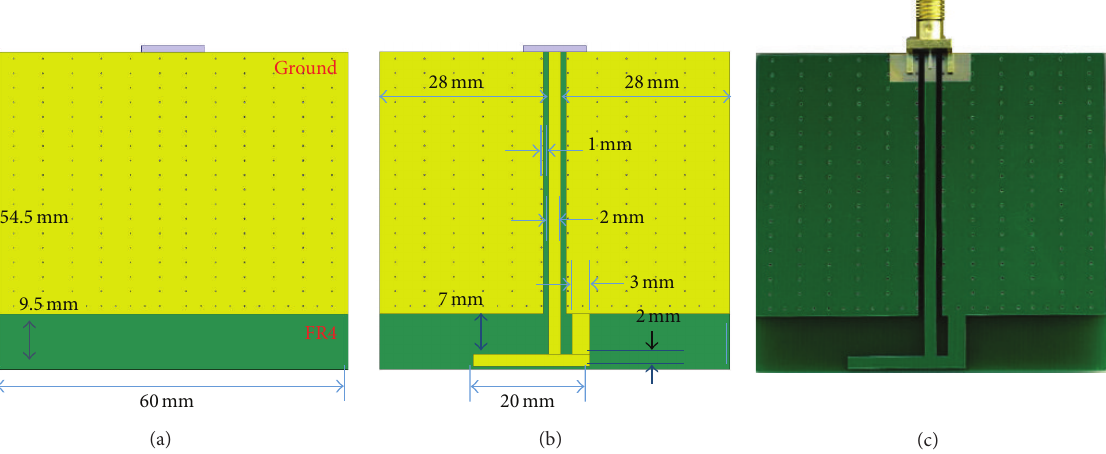
Figure 1: Configuration of the PIFA antenna: (a) bottom view, (b) top view, and (c) photograph of the PIFA antenna.